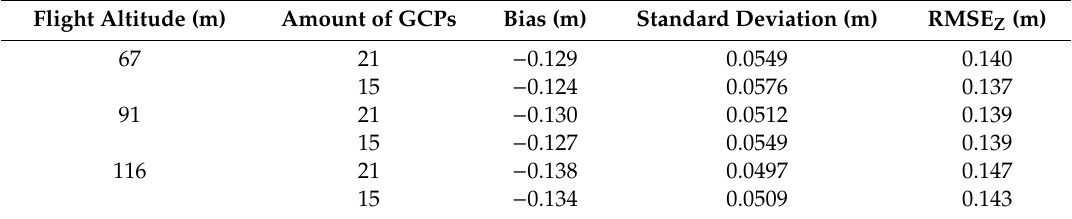
Table 3. UAS survey flight altitude accuracy assessment with RTK GPS walker data. RMSE: root mean square error.